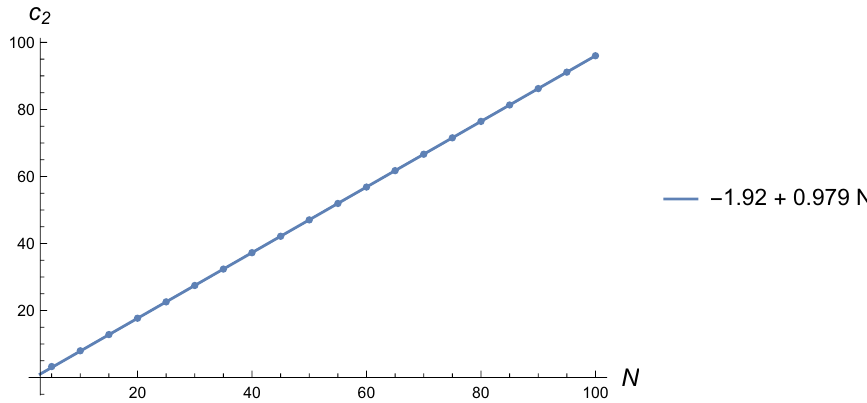
Figure 2 . Contribution of the two particle states to the total central charge as a function of N . Dots represent the numerical values and the solid line represents the best linear (cid:12)t applied for points with N 20 only. The values of c 2 for small values of N di(cid:11)er notably from the linear (cid:21)